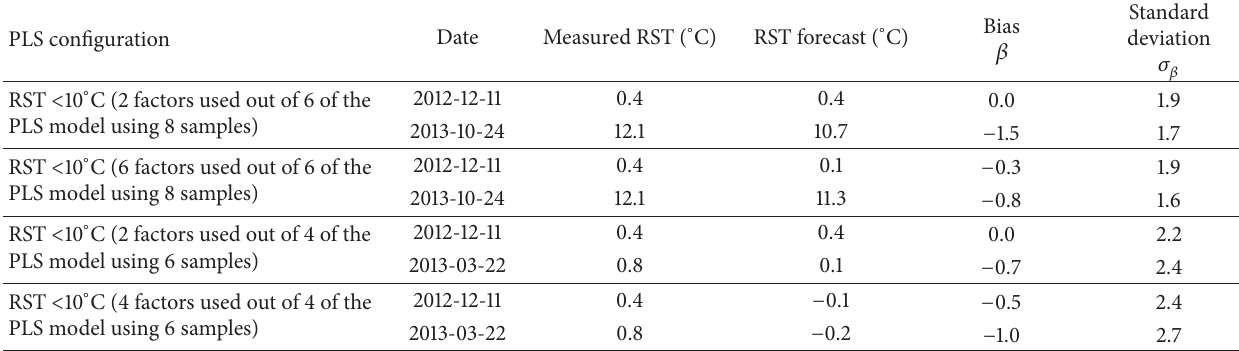
Table 3: Results of PLS models with optimum number of thermal